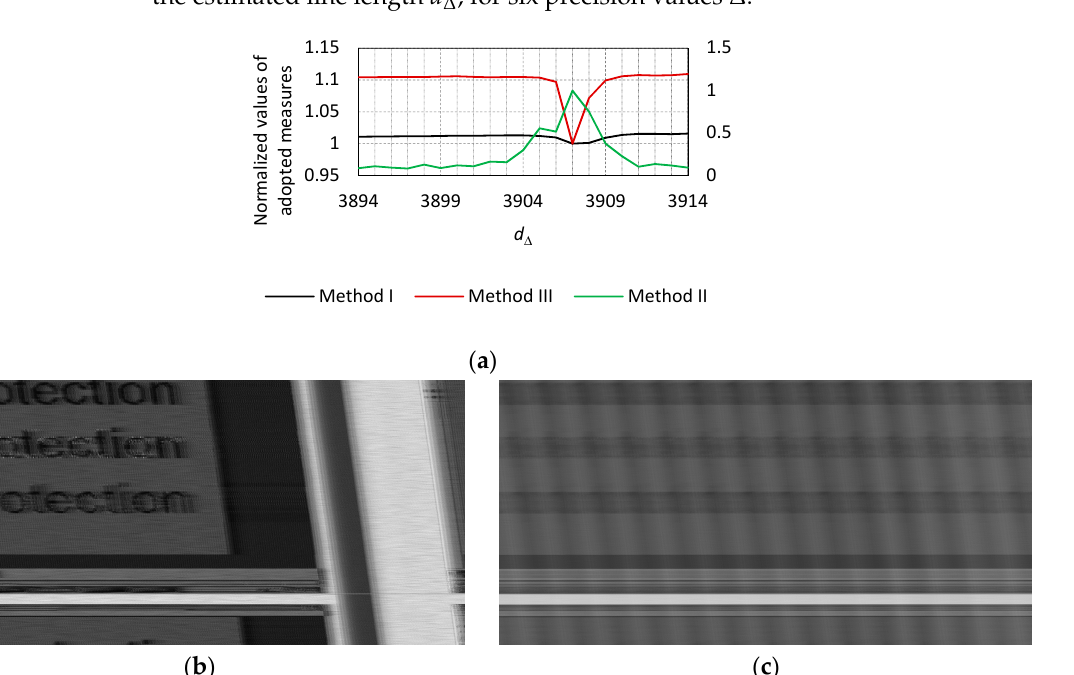
Figure 7c as a Primary Image, Monitor Mode 1280 × 1024/60 Hz, Pre-Estimated Value D Ent = 3904.00000